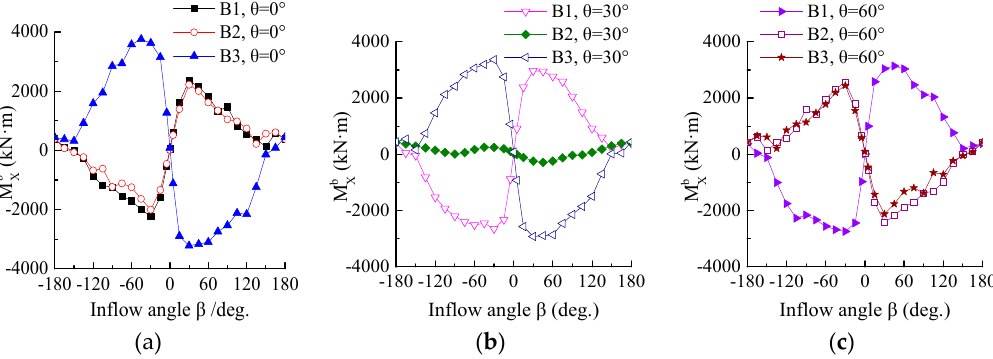
Figure 12. Moments M b of the three blades in the wind rotors for different parking positions: ( a ) θ = 0 ˝ parking position; ( b ) θ = 30 ˝ parking position; ( c ) θ = 60 ˝ parking